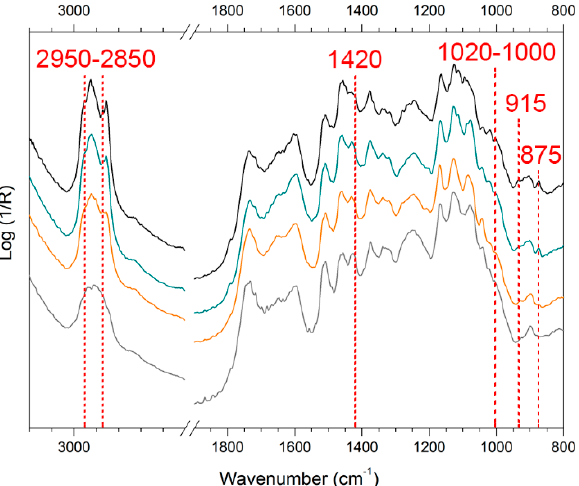
Figure 9. Reflection Fourier Transform Infrared (FTIR) spectra in pseudo-absorbance acquired on soiled-EAM (black), area cleaned with SA_3 (green) and KG_3 (orange) gels, a reference of EAM without soiling mixture (gray). The marker bands selected for identifying soiling mixture and synthetic sweat components are reported.